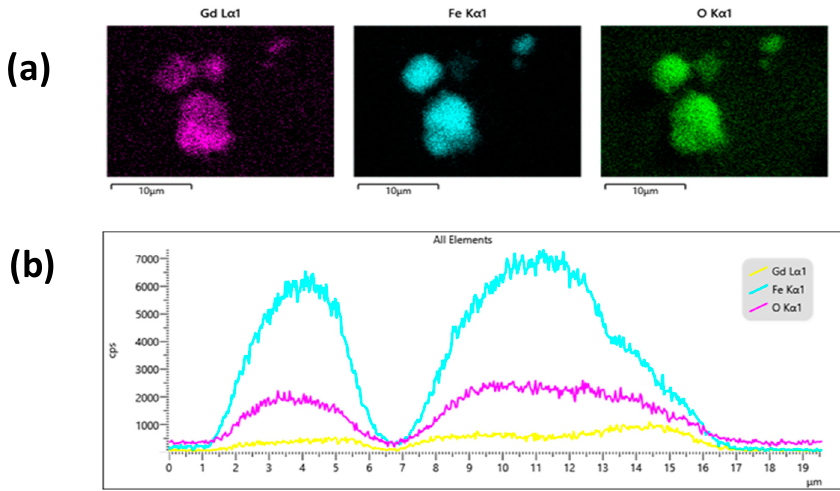
Figure 6. ( a ) Elemental mapping of the elements found in Mag@Gd(OH) 3 . ( b ) Line scan showing the distribution of the elements along a line over a determined region.